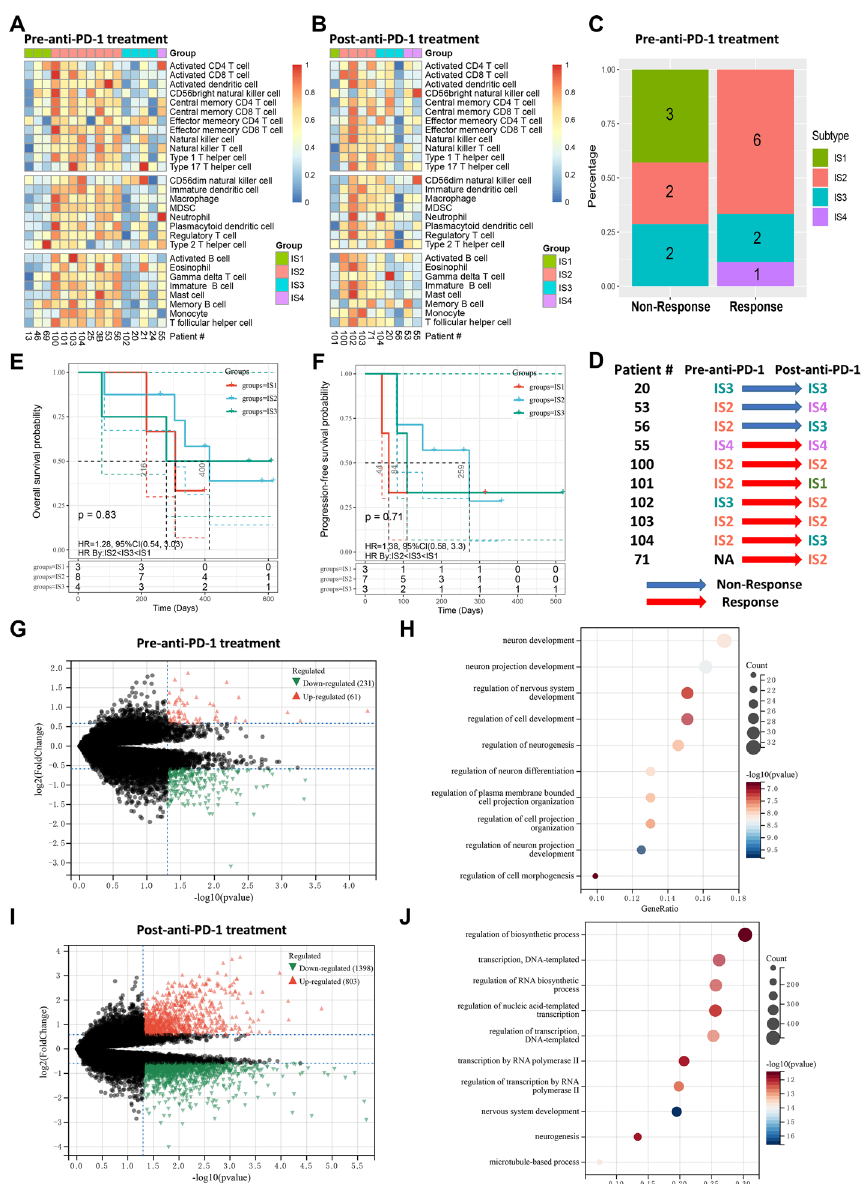
Fig. 9 The role of immune subtypes in anti-PD-1 treatment cohort. Heatmaps of 28 previously reported immune cells infiltration among GBM immune subtypes in the pre-anti-PD-1 treatment group ( a ) and post-anti-PD-1 treatment group ( b ). c Distribution of immune subtypes among responders and non-responders in pre-anti-PD-1treatment samples. d Changes of immune subtypes in paired pre- and post-anti-PD-1 treatment samples. e Kaplan–Meier curve showing OS analysis of immune subtypes (IS1-IS3) in pre-anti-PD-1treatment samples. IS4 had only one sample and therefore was not included in this analysis. f Kaplan–Meier curve showing progression-free survival analysis of immune subtypes in pre-anti-PD-1treatment samples. IS4 had only one sample and therefore was not included in this analysis. Volcano plots showing DEGs between responders and non-responders in pre- ( g ) and post-anti-PD-1 treatment ( i ) samples. Red represented DEGs that were upregulated by responders relative to non-responders, while green represented DEGs that were downregulated. GO biological process enrichment analysis of DEGs between responders and non-responders in pre- ( h ) and post-anti-PD-1 treatment ( j )